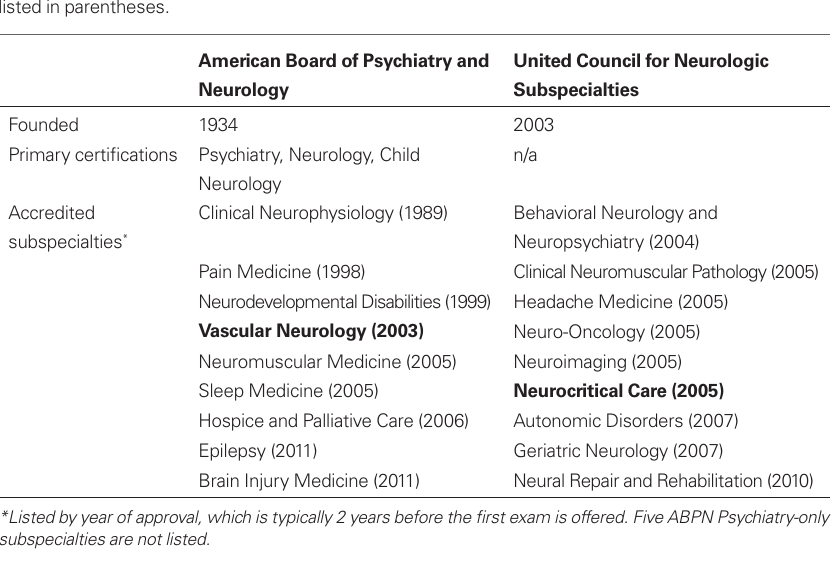
Table A1 | ABPN and uCNS specialties and subspecialties. The year each was initially accredited is listed in parentheses.